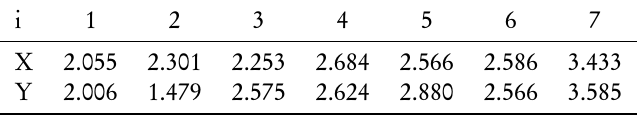
RSS observations from the strength for single carbon fiber under tension at gauge lengths 20mm (X) and 10mm (Y).